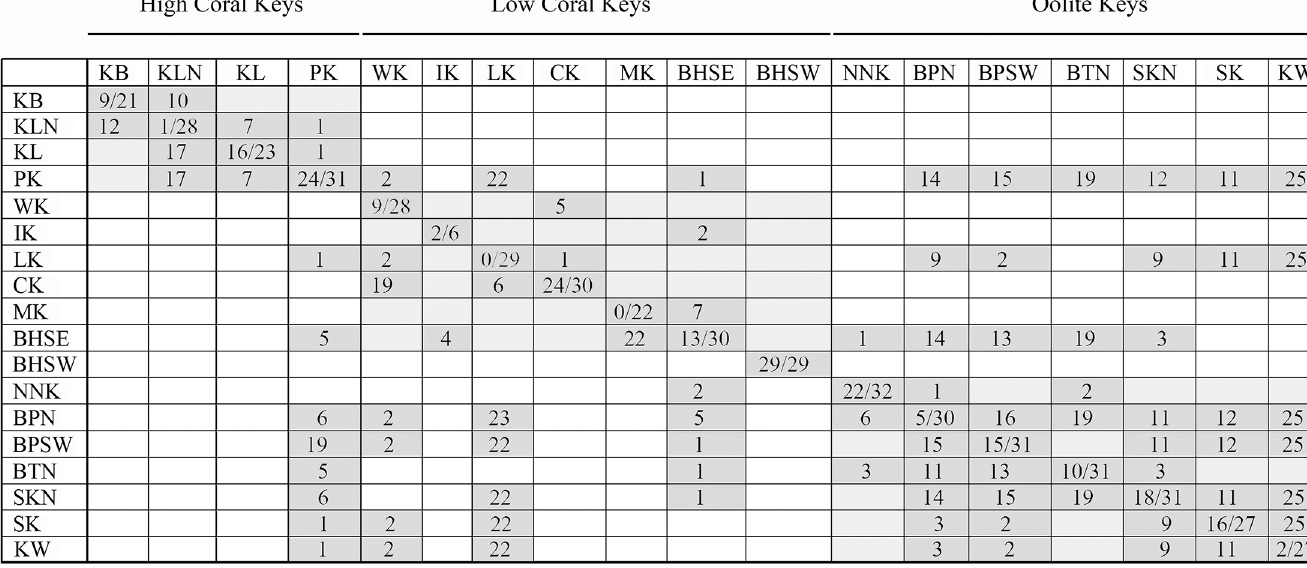
Fig 9. 16S haplotypes shared among Keys. Diagonal shows the number of specimens with haplotypes endemic to the Key / number of individuals sequenced from the Key for 16S. Rows indicate number of specimens on other Keys that have haplotypes that occur on specified Key. Columns indicate number of specimens on specified Key that share a haplotype with other